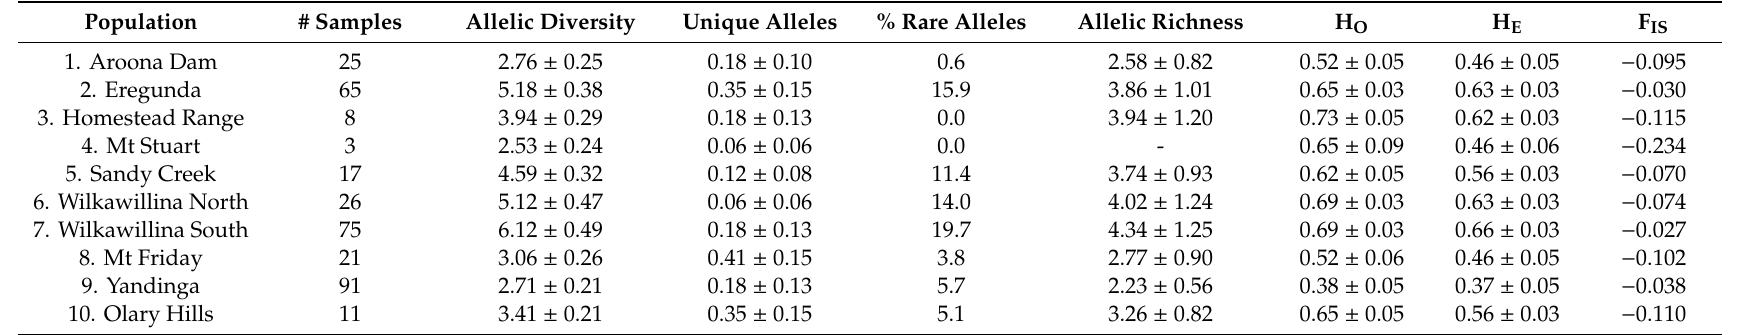
Table 2. Genetic diversity indices for microsatellite genotypes for 10 populations of Petrogale xanthopus xanthopus , including: the average number of samples analyzed in each population (# samples), allelic diversity, unique alleles, % rare alleles, allelic richness, i.e., the allelic diversity accounting for variation in sample size across populations (in this case accounting for N = 8), observed heterozygosity (H O ), expected heterozygosity (H E ), and inbreeding coe ffi cient (F IS ). Note: the F IS values are all not